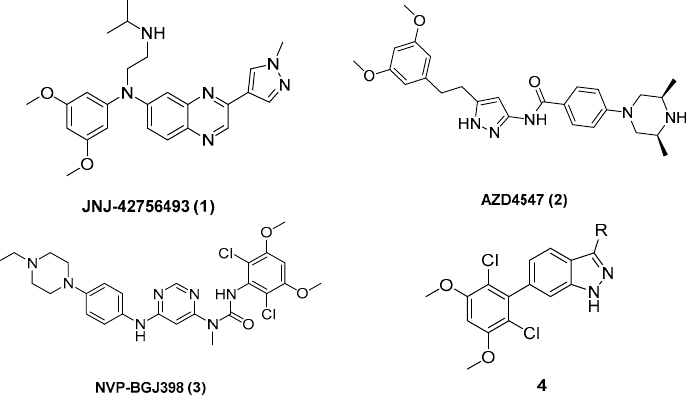
Figure 1. Structures of some representative selective FGFR inhibitors.